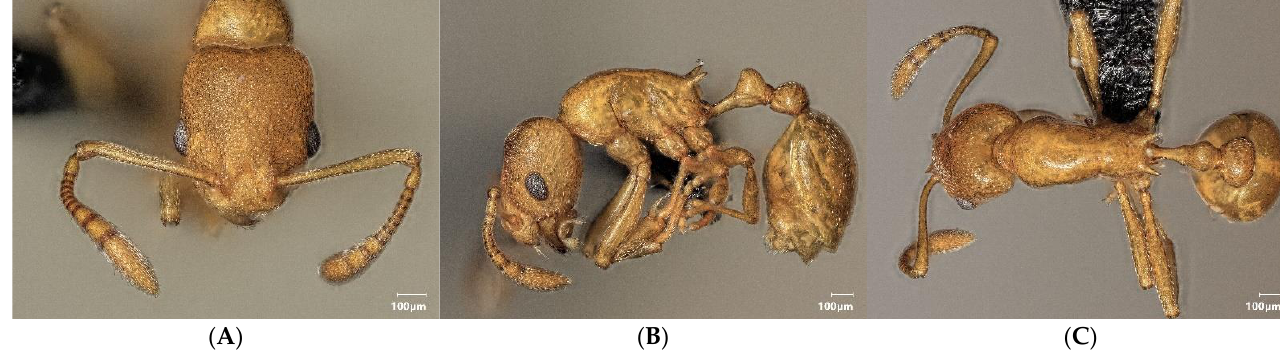
Figure 27. Cardiocondyla papuana : head in dorsal view, ( A ), lateral view ( B ), dorsal view ( C ). 4.4. Treatment by Species The reasons for identification of a taxon are given in square brackets after taxonomic name, author and year. 4.4.1. Cardiocondyla minutior Forel, 1899 Cardiocondyla nuda var. minutior Forel, 1899 [type investigation] This taxon has been described from Hawaii. Investigated were three syntype workers labelled “C. nuda Mayr v. minutior type Forel, Hawai” and Molokai Mts., 3000 ft. Perkins 1893 ” ; depository MHN Genève. Cardiocondyla tsukuyomi Terayama, 1999 [junior synonym, type investigation] This taxon has been described from the island of Ada in the Okinawa Archipelago. Investigated were six paratype workers from the holotype nest labelled “ VI 1988 K. Yamauchi leg., Ada, Okinawa-jima Okinawa Pref. ” and “ Cardiocondyla tsukuyomi Ter- ayama, 1999 ” ; depository SMN Görlitz. The synonymization with C. minutior has already been stated by Seifert [9]. For a more comprehensive argumentation see below under tax- onomic comments and clustering results. Cardiocondyla breviscapus Seifert, 2003 [junior synonym, type investigation] This taxon has been described from India. Investigated were the holotype and two paratype workers labelled “ INDIA: Coimbatore 25.ix.79 J. Noyes ” and “ Holotype Cardio- condyla breviscapus Seifert ” or “ Paratypes Cardiocondyla breviscapus Seifert ” ; depository BMNH London. The introduction of this taxon was due to insufficient knowledge of in- traspecific variability in the year 2003. The recent exploratory and hypothesis-driven data analyses performed in a larger sample indicate a synonymy with C. minutior (see Section 4.4.1 under taxonomic comments and clustering results). All material examined . Including those single-specimens samples with wild-card LDA classifications having posterior probabilities p > 0.95, numeric phenotypical data